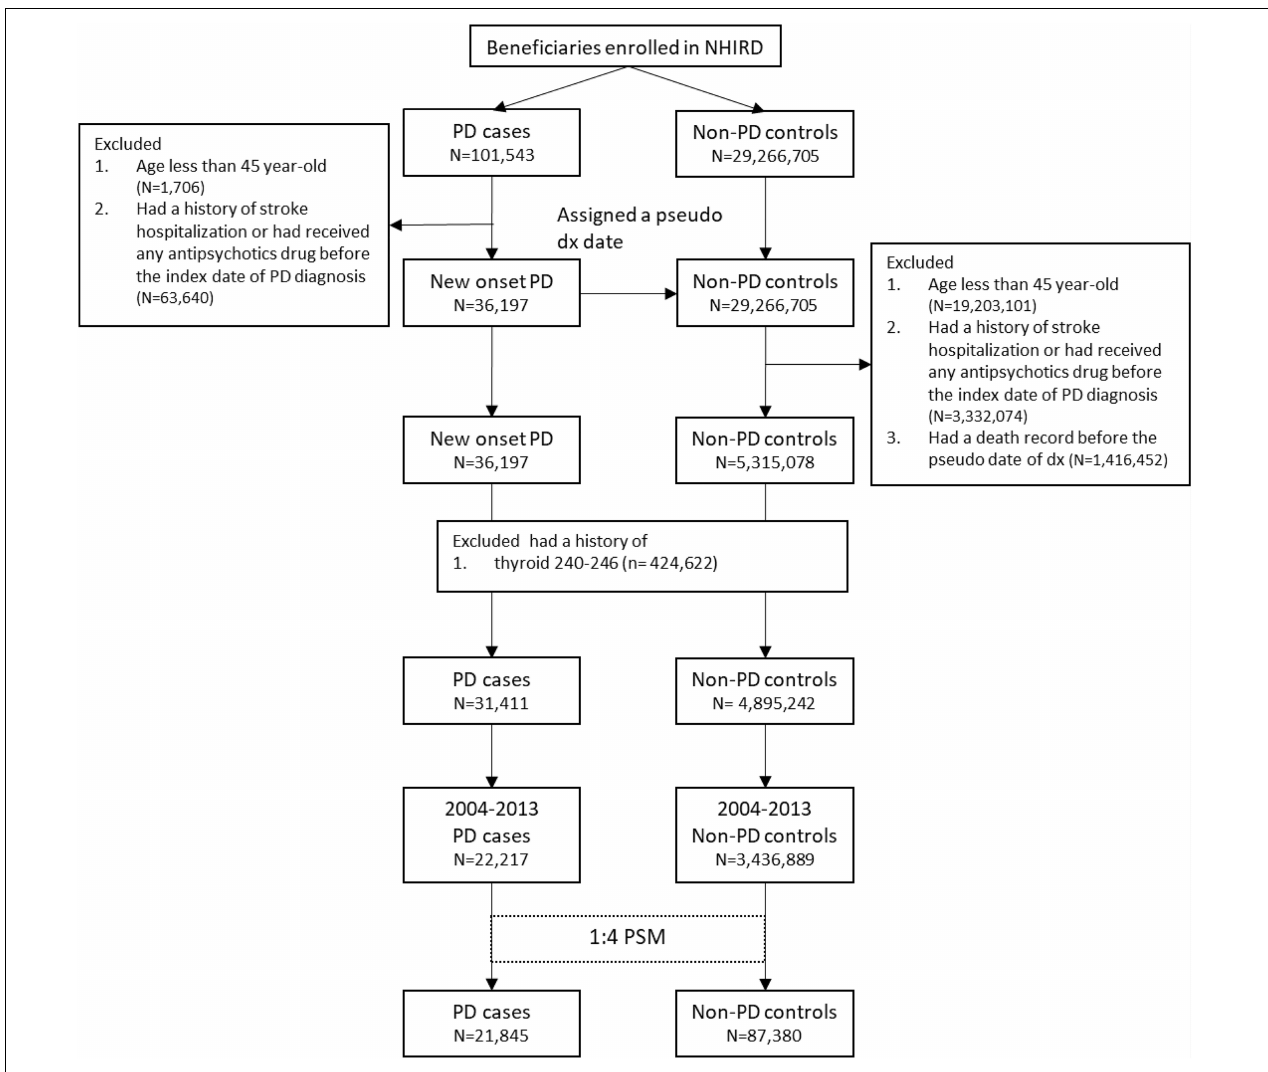
FIGURE 1 | Flowchart of patient